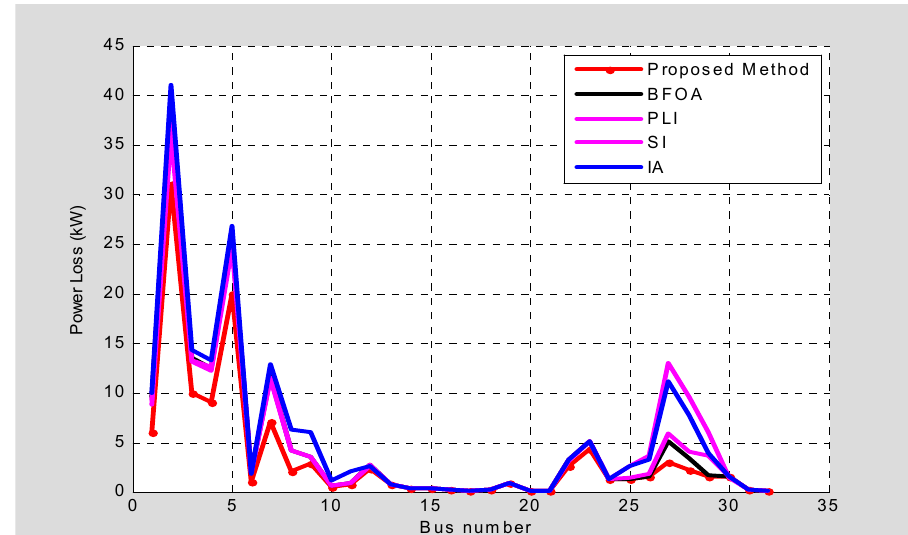
Figure 11. Comparison of performance of line losses for standard 33 bus system.